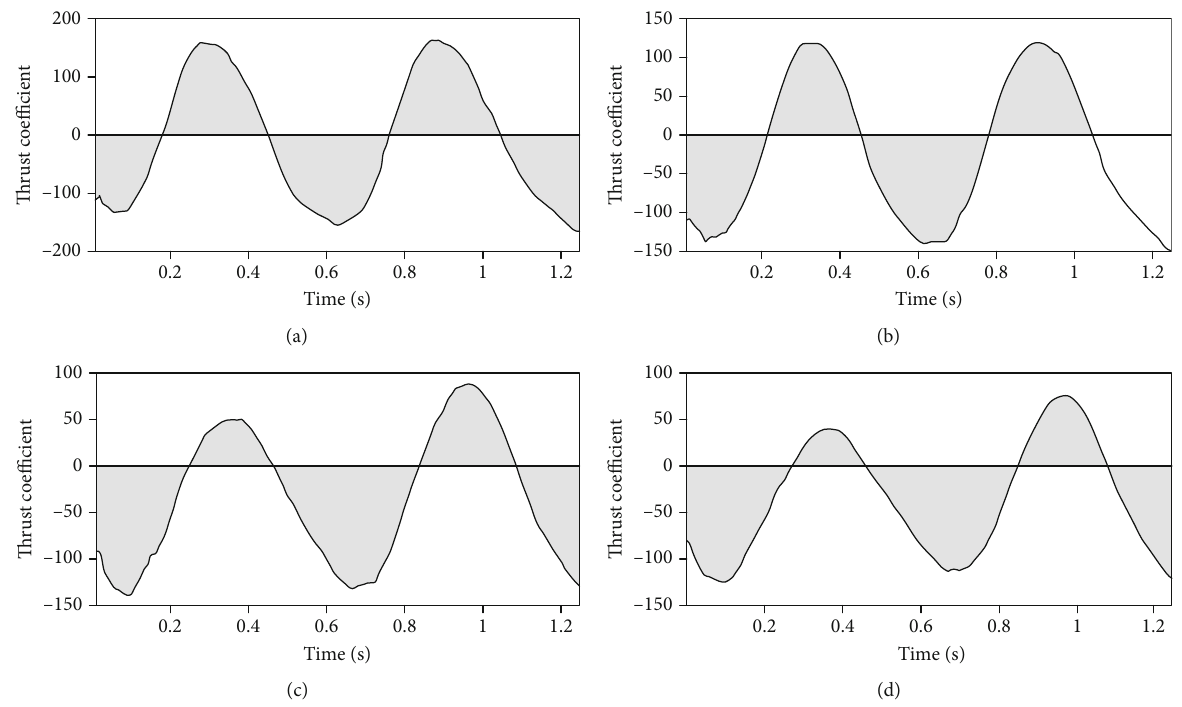
Figure 8: Resistance coe ffi cient versus time in a cycle under di ff erent phase di ff erence. (a) Phase di ff erence is 30 ° , angle of attack is 31.7 ° ; (b) phase di ff erence is 40 ° , angle of attack is 28.4 ° ; (c) phase di ff erence is 50 ° , angle of attack is 25.6 ° ; (d) phase di ff erence is 60 ° , angle of attack is 21.6 ° .